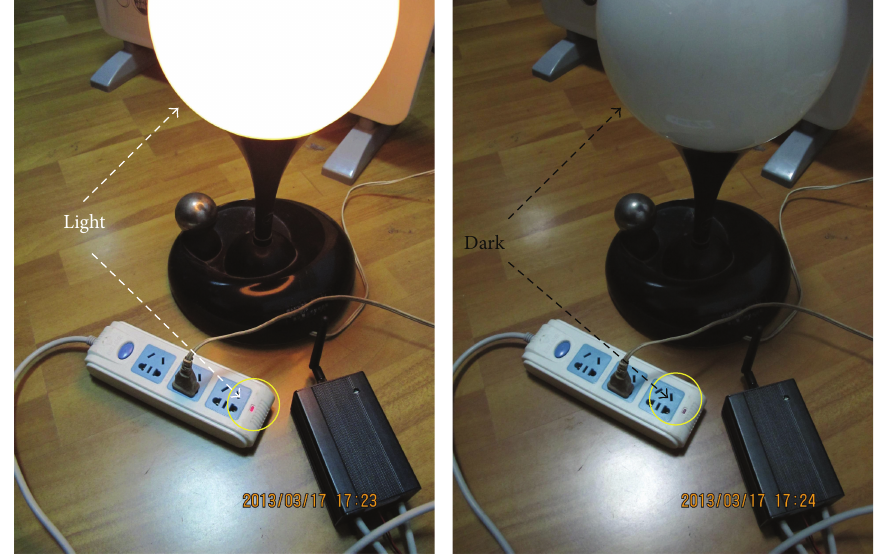
Figure 8: Control module in